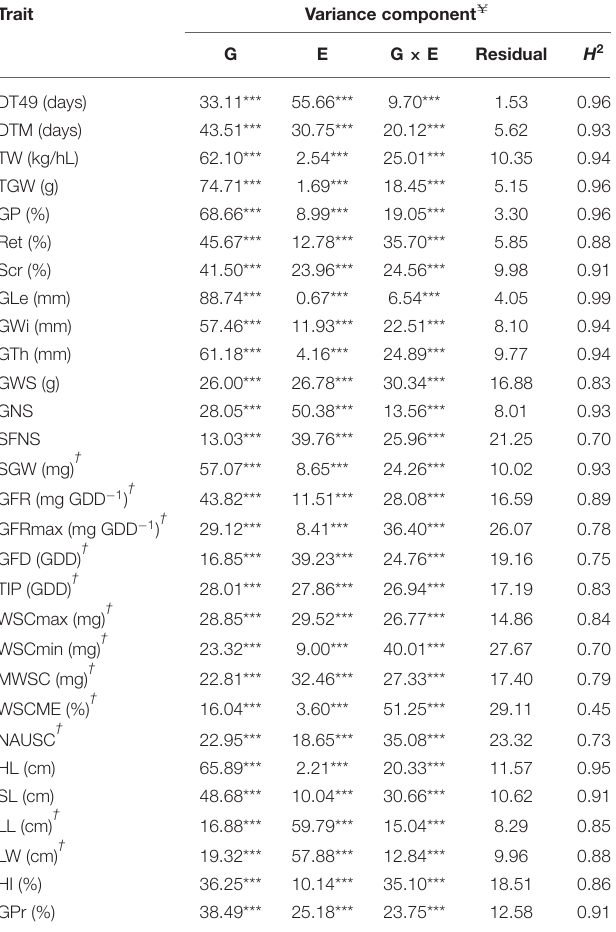
TABLE 2 | Percent of variance attributable to genetic (G), environment (E), G × E, and other effects, and broad-sense heritability estimates ( H 2 ). Trait Variance component U